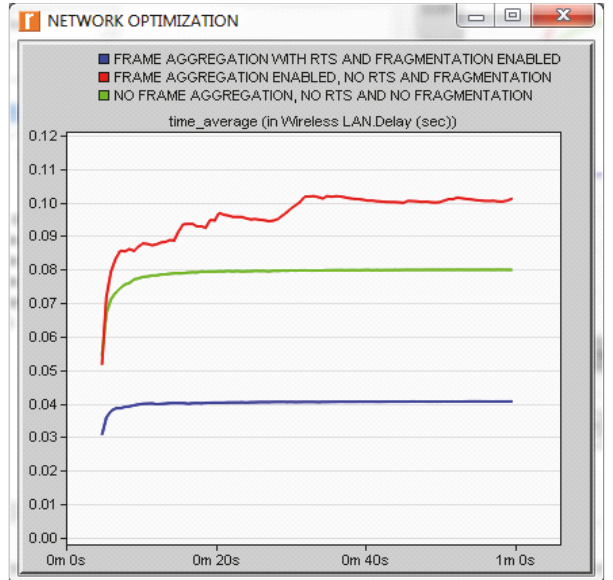
Figure 39: WLAN delay with and without RTS and fragmentation mechanisms.